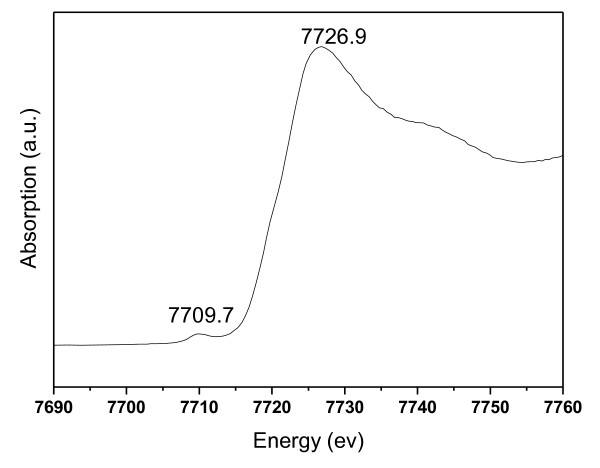
XANES of Co-SiO2.